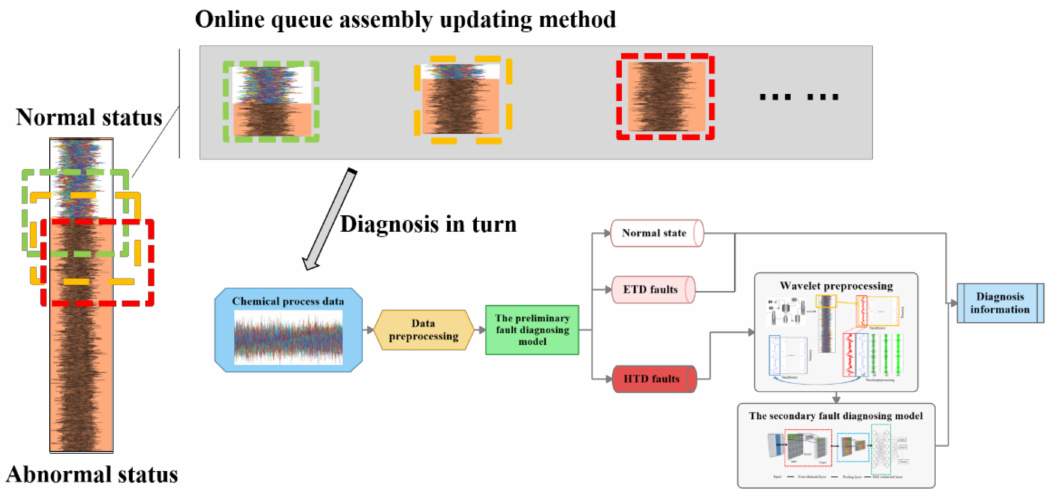
Figure 3. The pipeline of the wavelet transform-assisted convolutional neural network (WCNN) multi-model monitoring method. Three di ff erent color dashed boxes represent the data matrices, input into the WCNN model, obtained through the online queue assembly updating